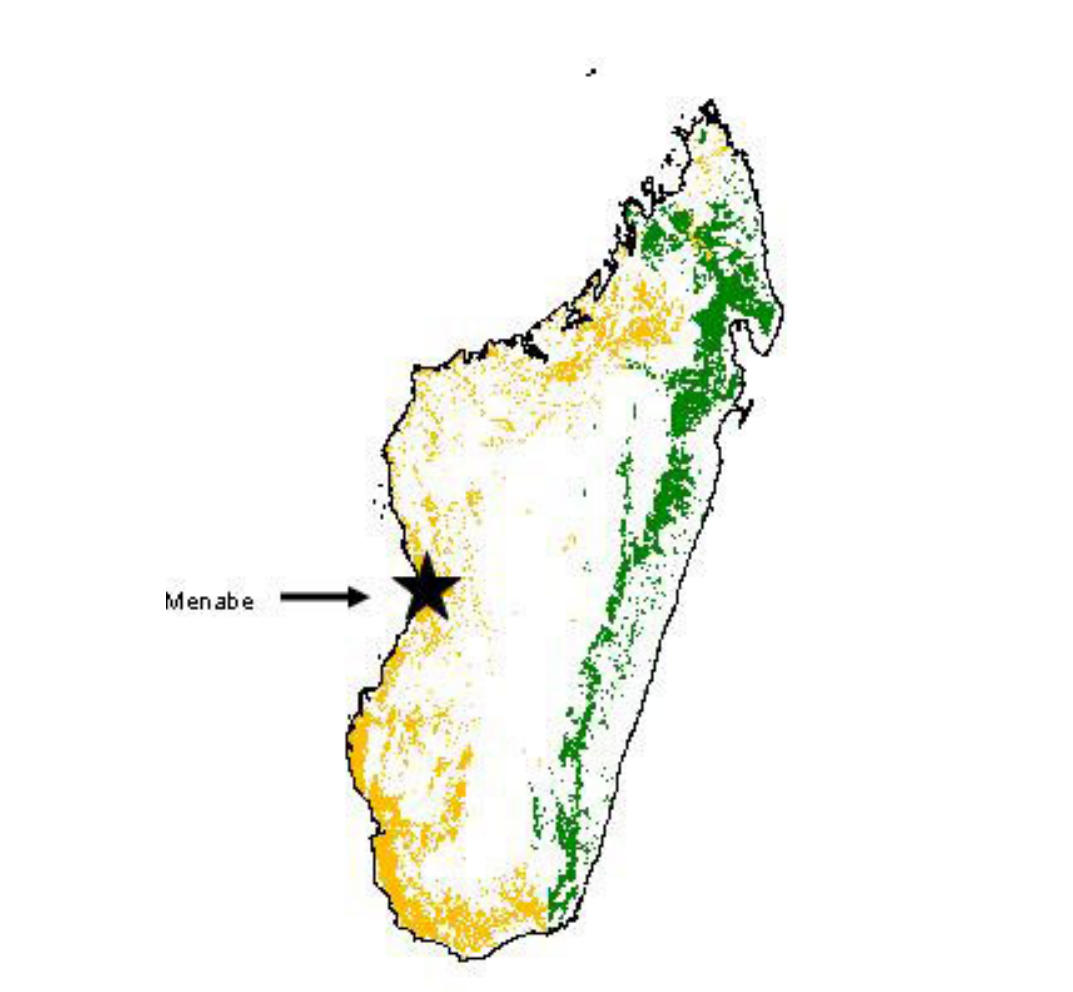
Fig. 2 . Map of Madagascar indicating location of Menabe